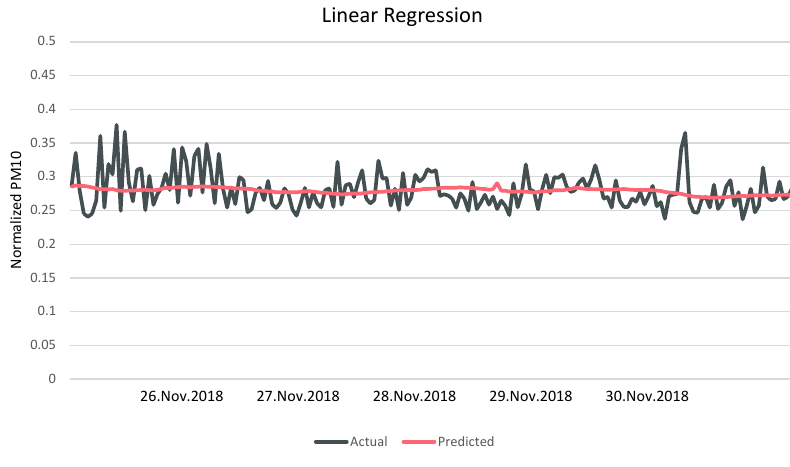
Figure 9. Comparison between the Linear Regression prediction and the test data.